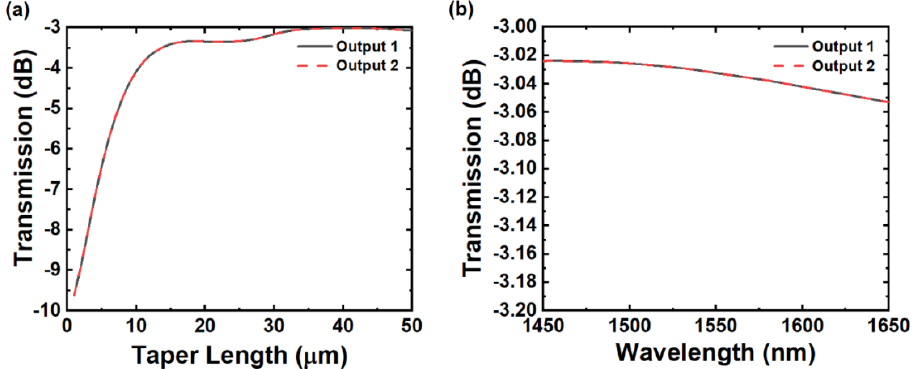
Figure 3. Simulated transmission result. (a) Taper length span; (b) wavelength sweep over 200-nm bandwidth.